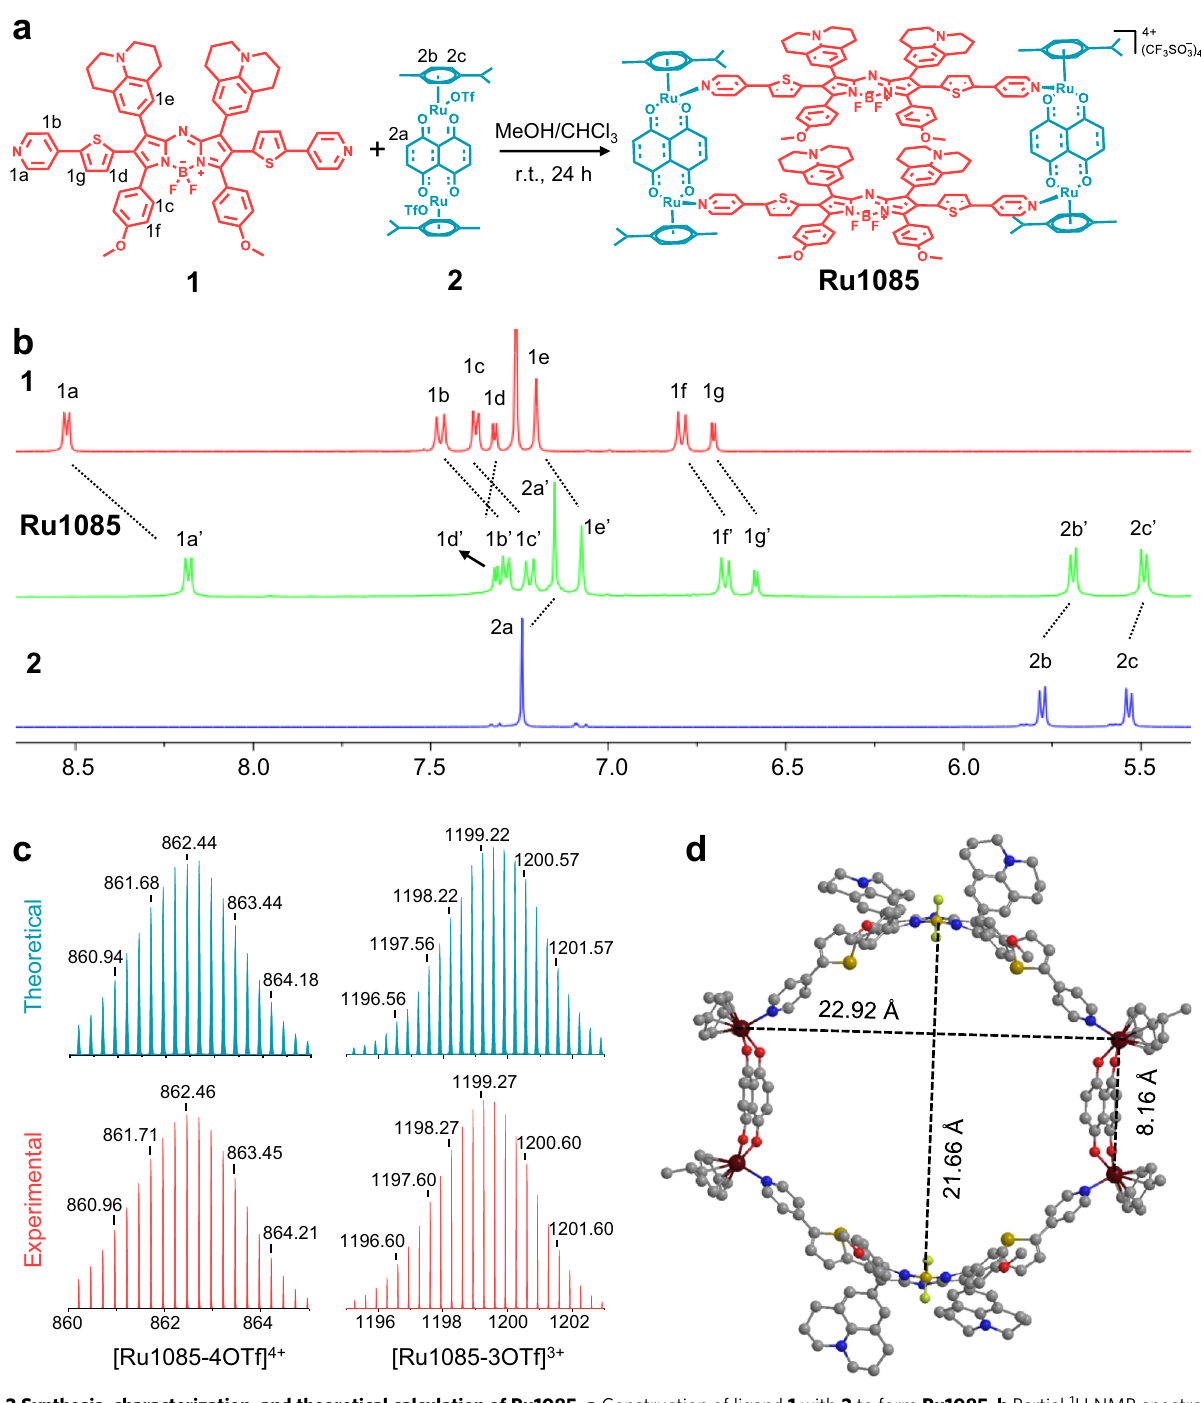
Fig. 2 Synthesis, characterization, and theoretical calculation of Ru1085. a Construction of ligand 1 with 2 to form Ru1085 . b Partial 1 H NMR spectra of 1 , Ru1085 and 2 (from top to bottom). c Theoretical (blue) and experimental (red) isotope patterns of [ Ru1085 – 4OTf] 4 + (left) and [ Ru1085 – 3OTf] 3 + (right) for ESI-TOF-MS. d Molecular model of Ru1085 optimized by B3LYP molecular orbital